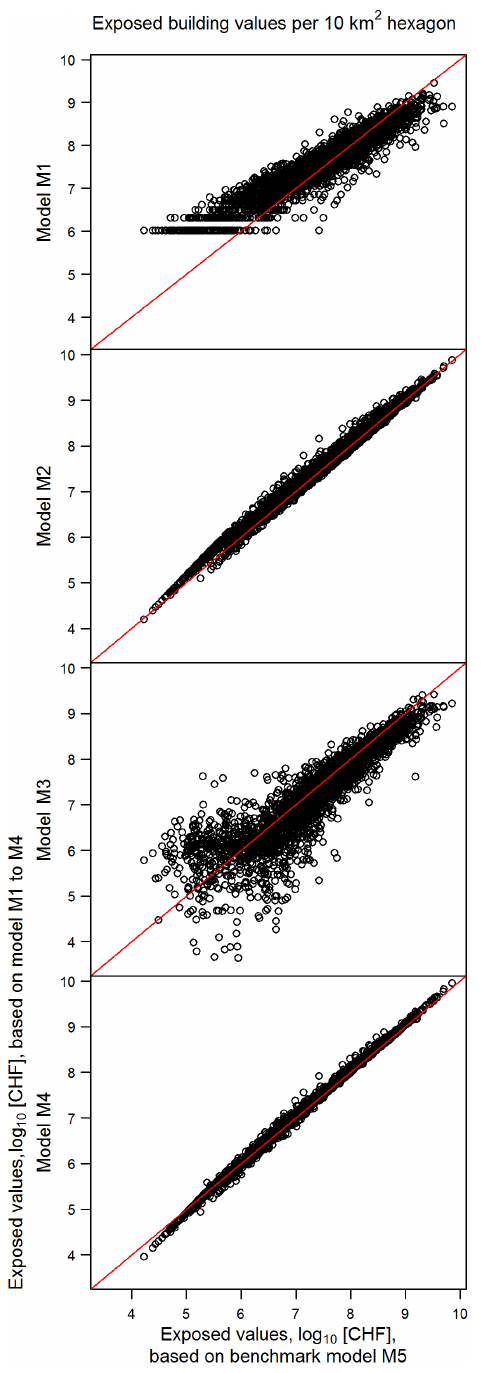
Figure 5. Scatter plot of flood-exposed-building values aggregated to regular hexagons with a surface area of 10km 2 . The sums based on models M1 to M4 ( y axis) are plotted against the sums based on the benchmark model M5 ( x axis). The red lines indicate the 1 : 1 relation. All values are log 10 transformed and sums below 10 4 CHF are not shown.